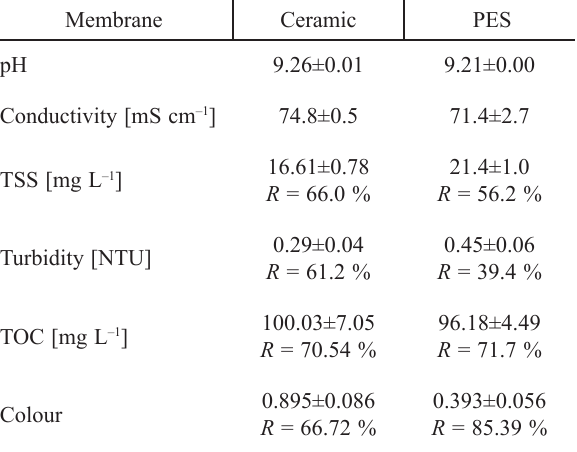
Table 3 – Characteristics of permeate samples and rejection rates of total suspended solids (TSS), turbidity, and total organ­ ic carbon (TOC), and colour intensity with the polyethersulfone (PES) and ceramic membranes for textile wastewater at T = 20 °C